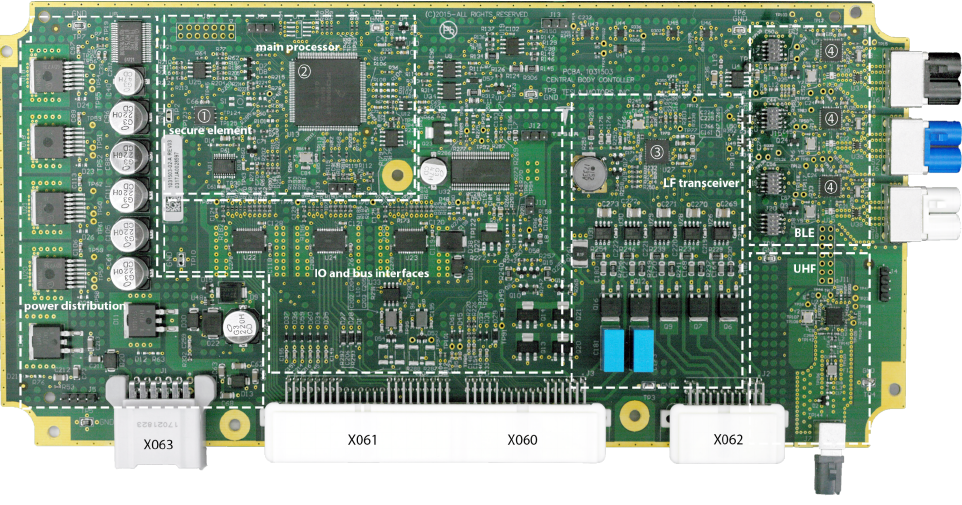
Figure 2: The Model X BCM PCB (top side). The main components are: (1) Infineon SLM97CFX1M00PE Secure Element, (2) Freescale SPC5605B, (3) Maxim Integrated MAX2143A 22 kHz transceiver and (4) Texas Instruments CC2541 BLE